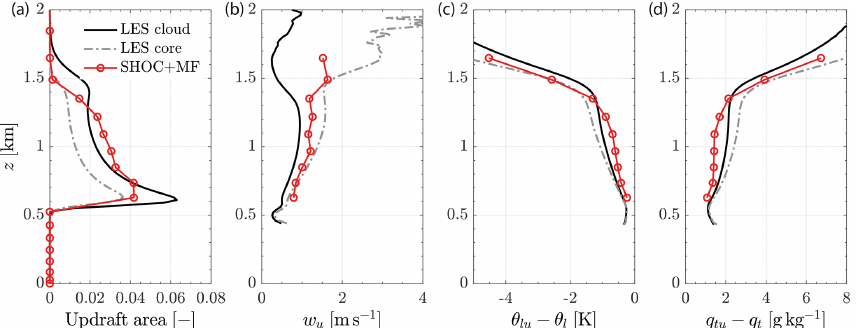
Figure 2. Vertical profiles of moist updraft properties for the BOMEX case. (a) Updraft area, (b) updraft vertical velocity, and excess relative to the grid-mean values of (c) liquid water potential temperature ( θ lu − θ l ) and (d) total water mixing ratio ( q tu – q t ). The solid black lines correspond to the LES cloud sampling, the dashed grey lines to the LES cloud core sampling, and the solid red lines to SHOC + MF. The profiles correspond to a time average over t = 4–6h.